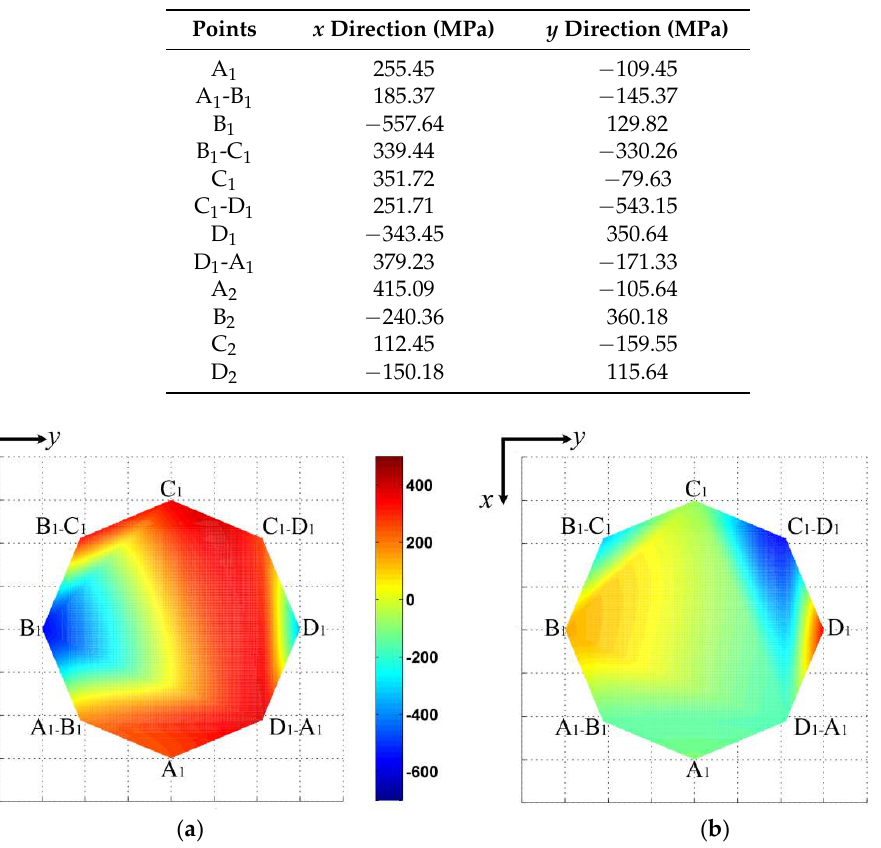
Table 2. Stress in plastic-deformed area of Specimen 2#.